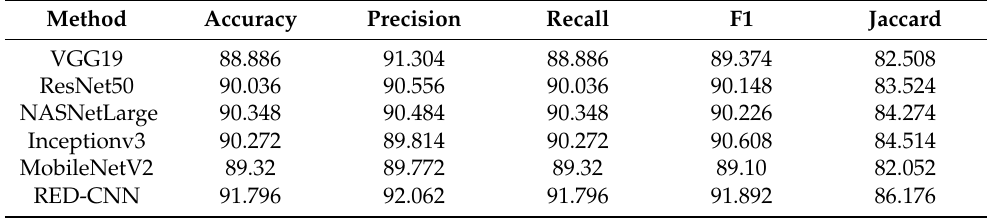
Table 4. Comparison of weighted average results of different